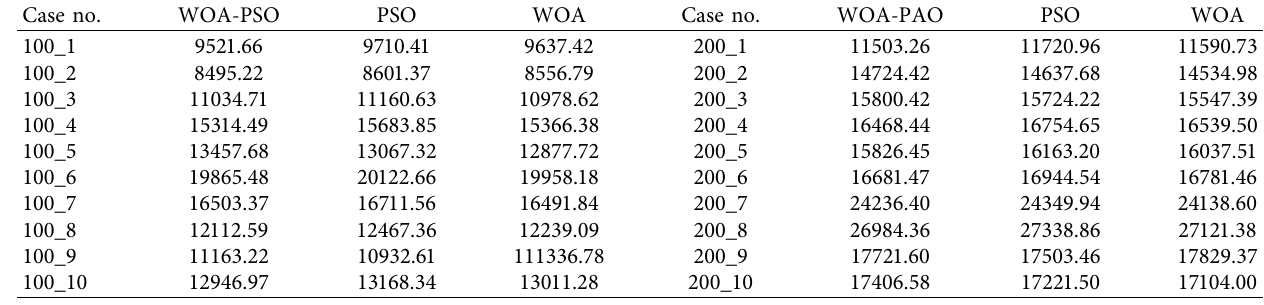
Table 5: Test results of large-scale examples.